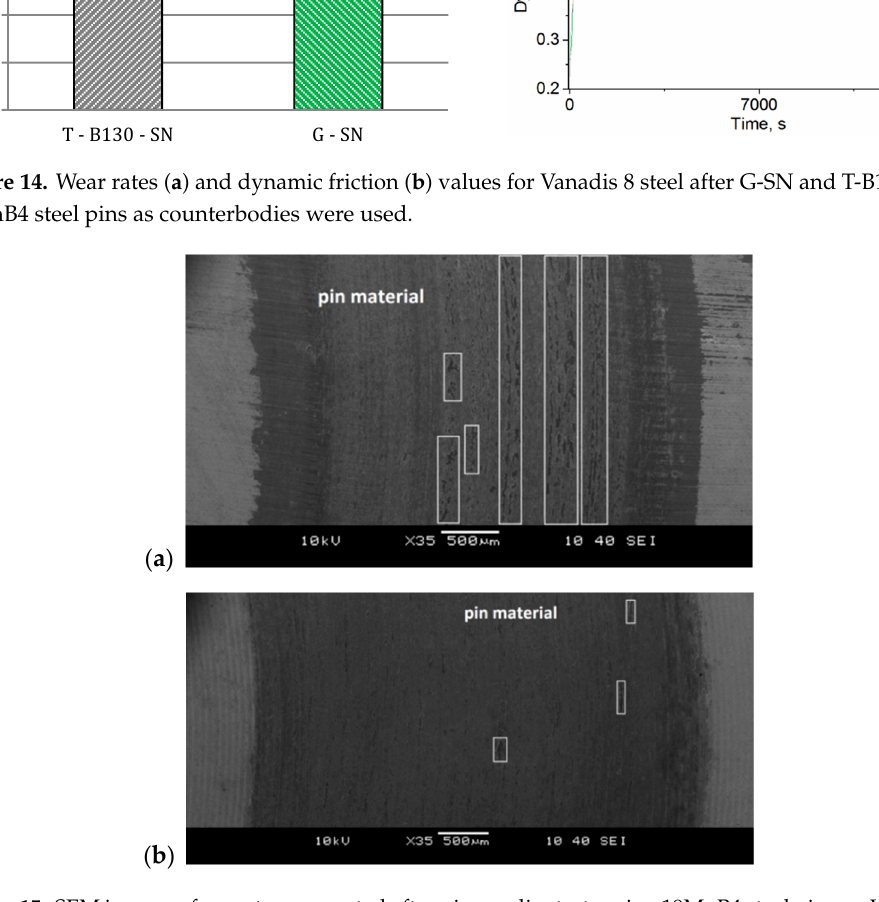
Figure 15. SEM images of wear traces created after pin-on-disc tests using 19MnB4 steel pins on